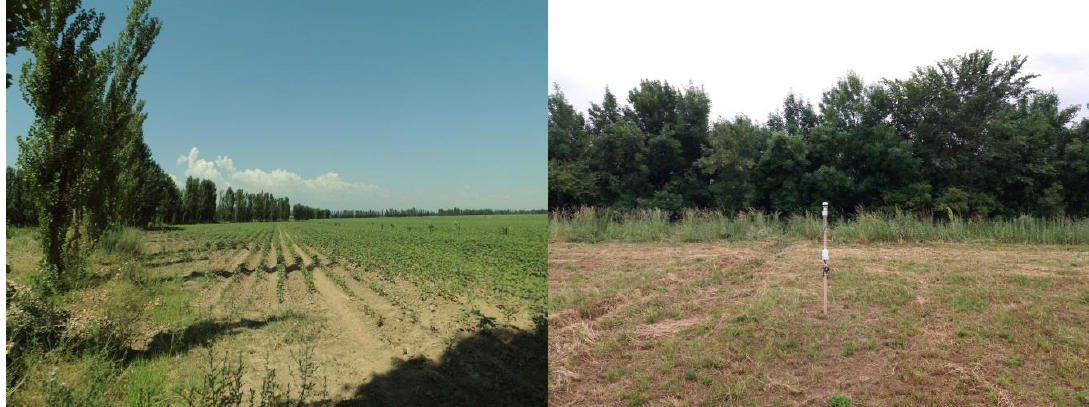
Figure 2. Single row tree wind break from poplars at the study site Chek ( left ) and multiple row wind break with elm and shrub understory vegetation in Temen Suu ( right ).